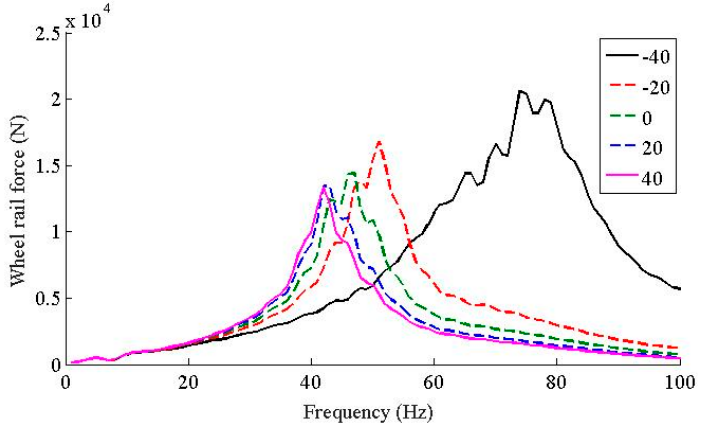
− 40, − 20, 0, 20, and 40 ◦